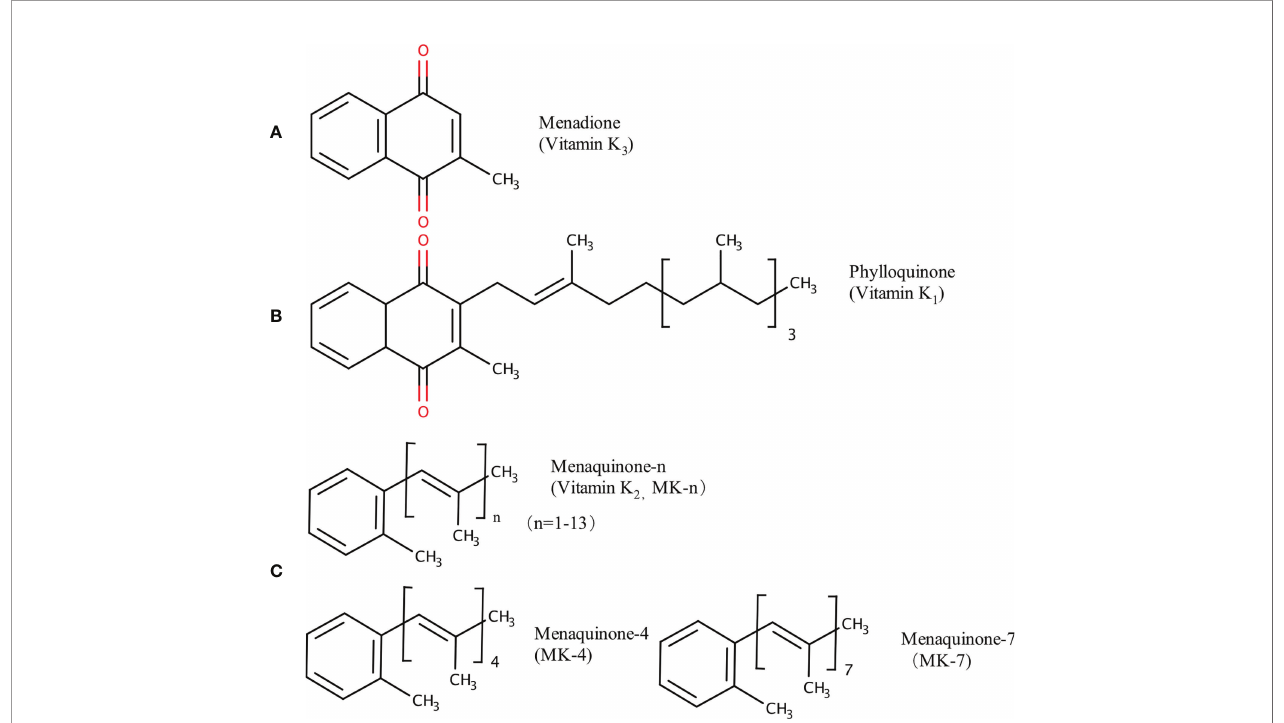
FIGURE 1 | Chemical structures of VK compounds: (A) 2-methyl-1,4-naphthoquinone (menadione, K 3 ), (B) 2-methyl-3-phytyl-1,4-naphthoquinone (phylloquinone, K 1 ), and (C) when n = 4 and 7, 2-methyl-3-geranyl-geranyl-1,4-naphthoquinone (menaquinone-4, MK-4) and 2-methyl-3-all-trans-farnesyldigeranyl-1,4- naphthoquinone (menaquinone-7, MK-7) are the two common forms of menaquinones (VK 2 ). The fi gure is in non-editable format.